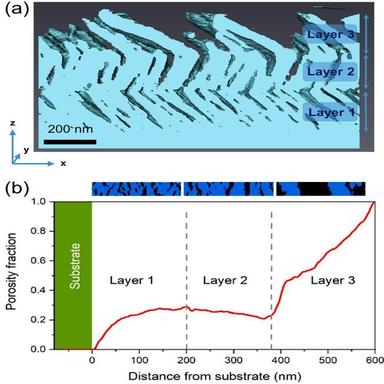
(a) STEM-HAADF 3D reconstruction of a TiO2/SiO2 OAD trilayer. (b) Associated porosity profile extracted along the surface normal, together with some representative planar views of each layer obtained by data segmentation (voids are shown in black colours).